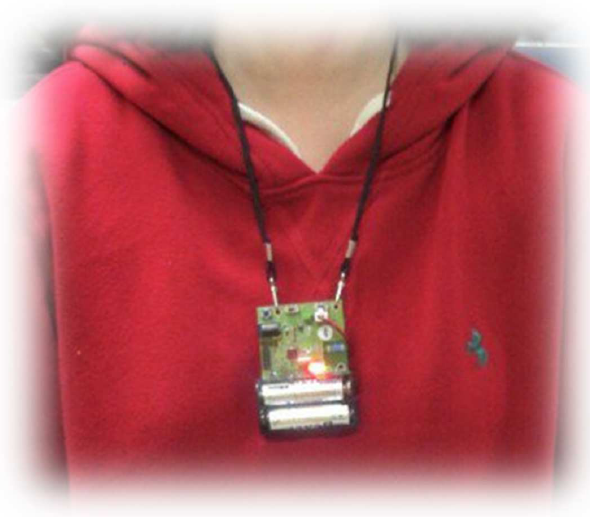
Figure 1. Photo of a person wearing a real edge device as a pendant to participant’s neck for implementing the proposed fall detection system.